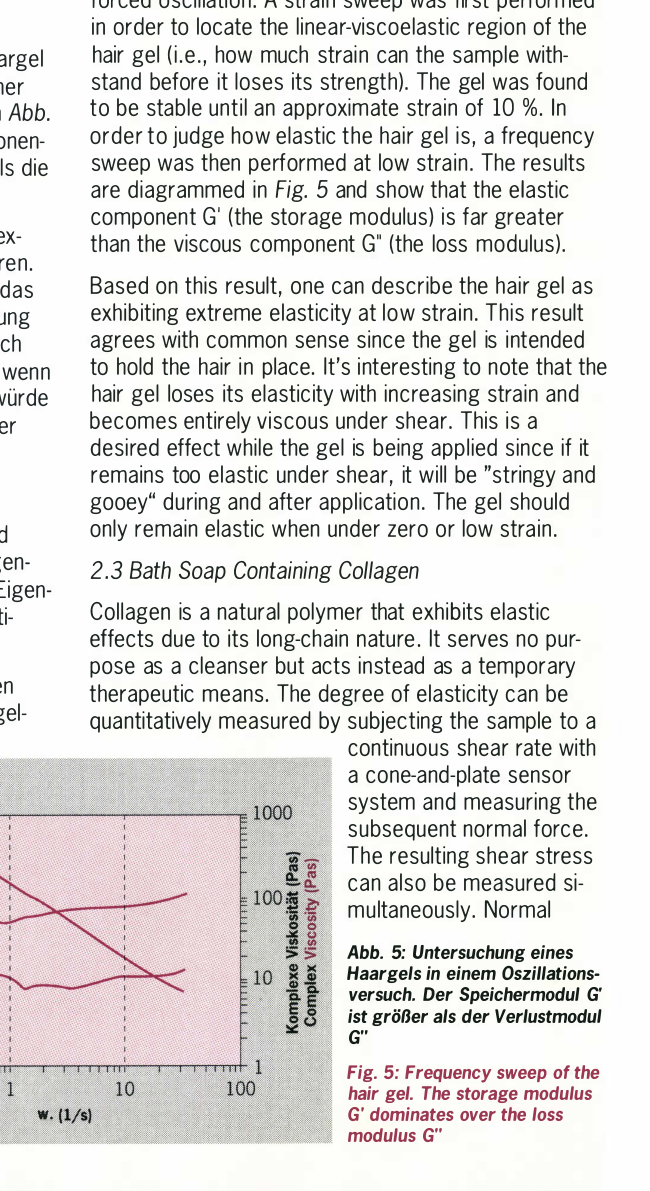
Fig. 5: Frequency sweep of the hair gel. The storage